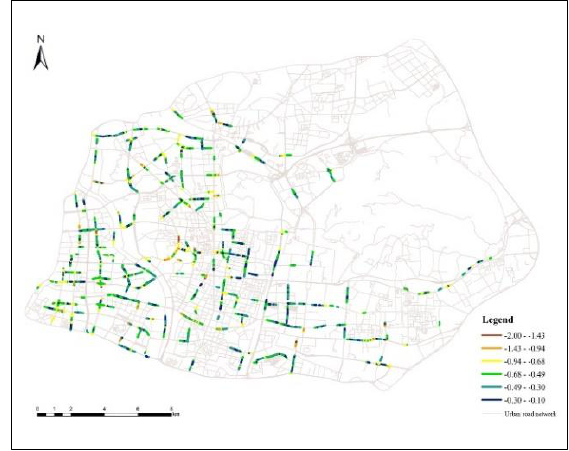
Figure 5 . Spatial distribution of roads with significant speed decline in all rainfall events